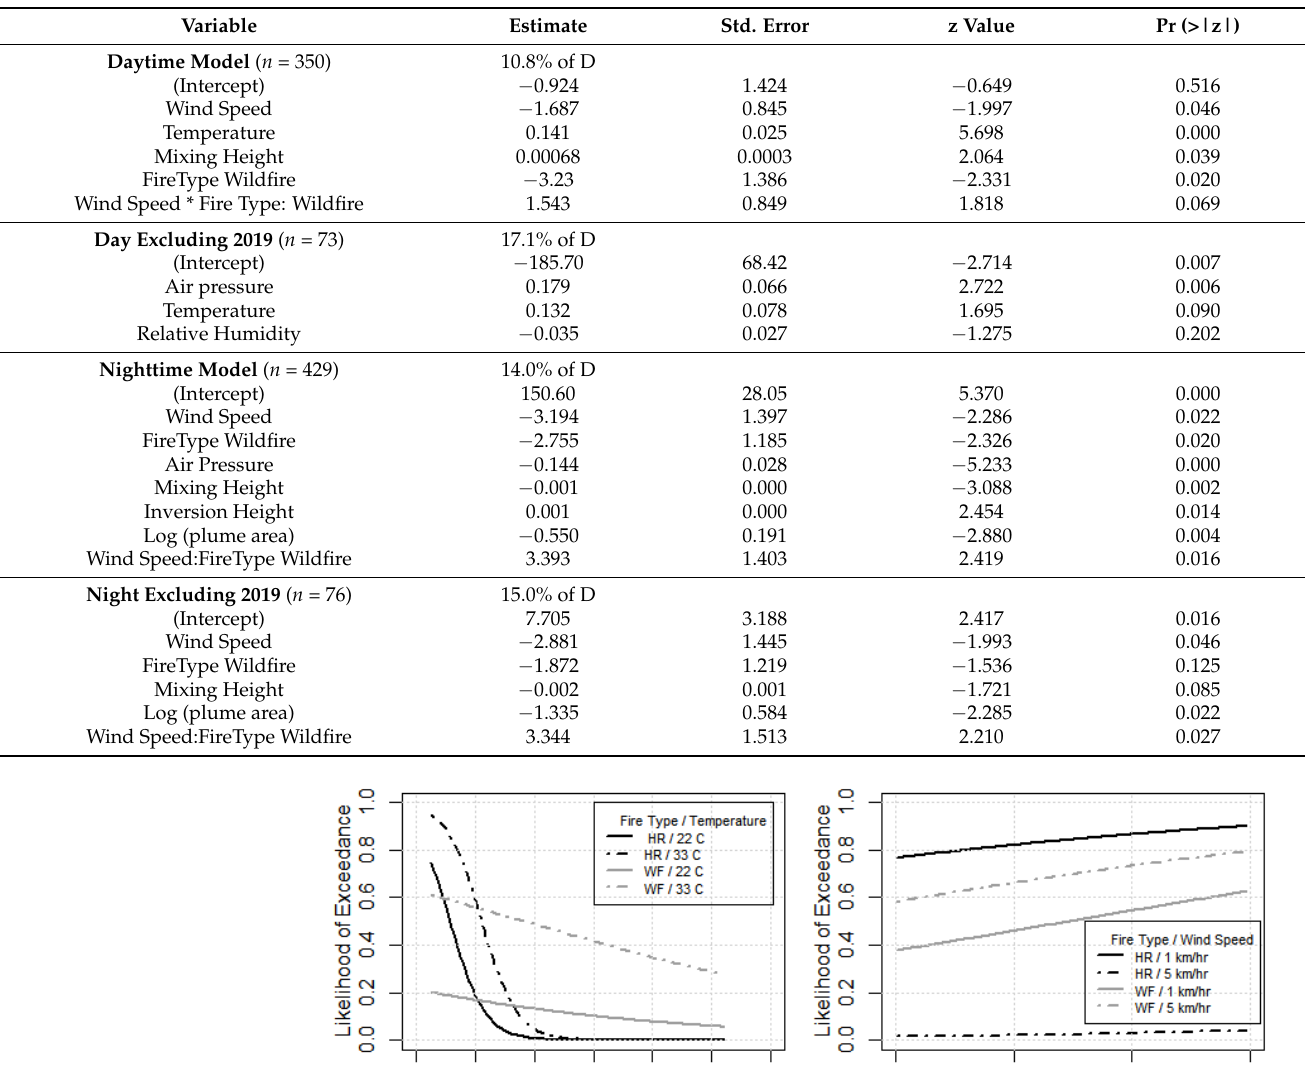
Table 2. Binomial regression models for daytime and nighttime observations of poor air quality exceedance. Each model was derived by fitting all predictors and testing the interaction with Fire Type for each selected variable. The table also shows the model for the subset of the data excluding the 2019-20 wildfires. An asterisk (*) indicates an interaction term.